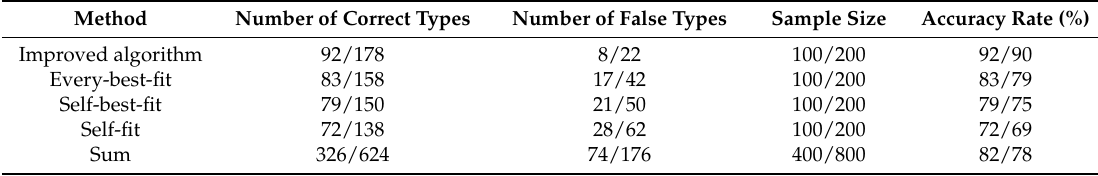
Table 3. Statistical results for different stroke generation methods.